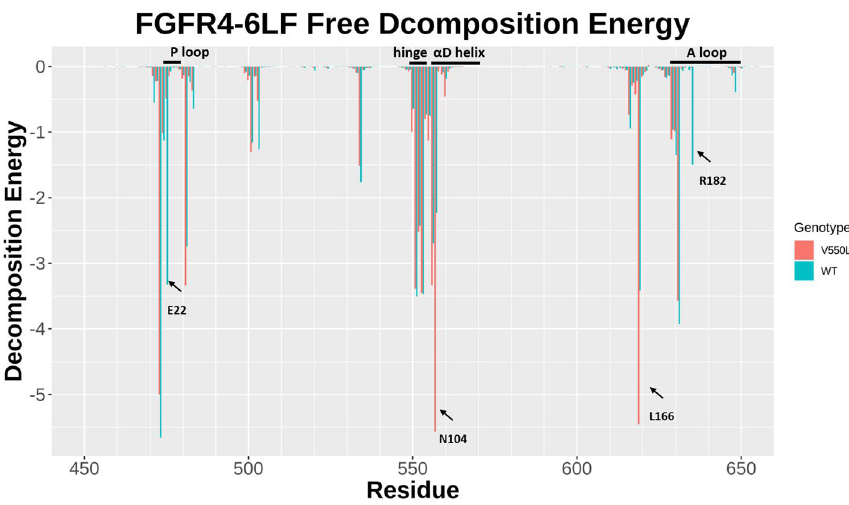
Figure 4. 6LF binding energy. Major FGFR4 residues that participate in 6LF binding are different between the WT and the V550L mutant. However, the total energy (kcal/mol) released upon ligand decomposition is approximately equal between the two proteins.